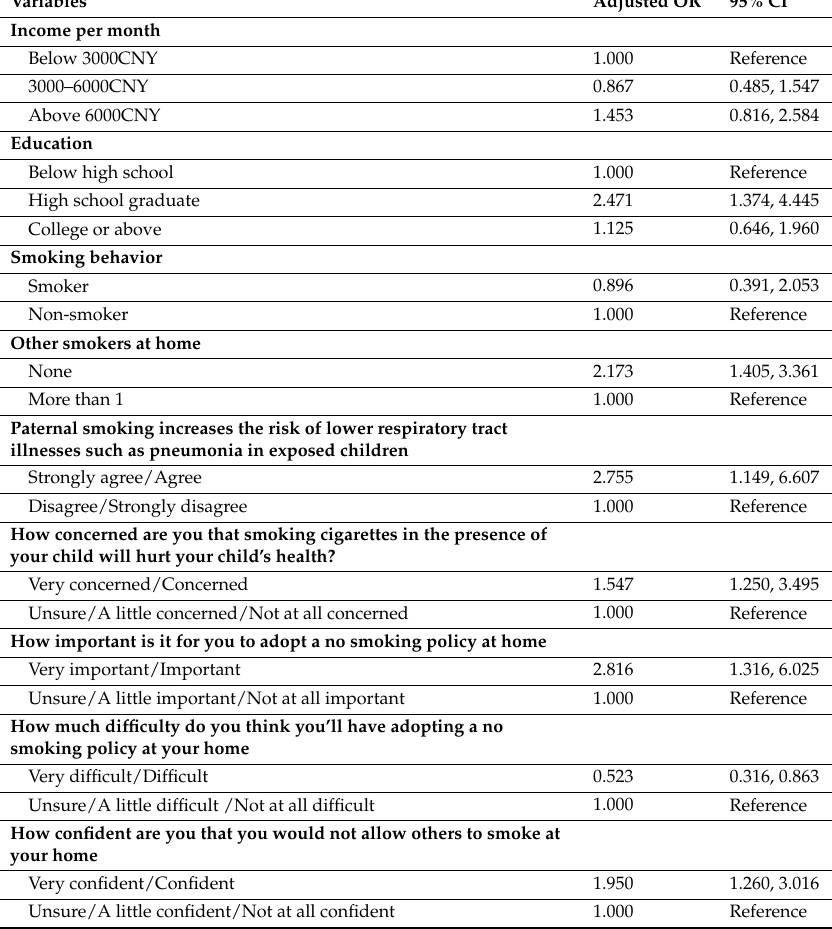
Table 3. Logistic regression model to identify predictors of having a complete home smoking